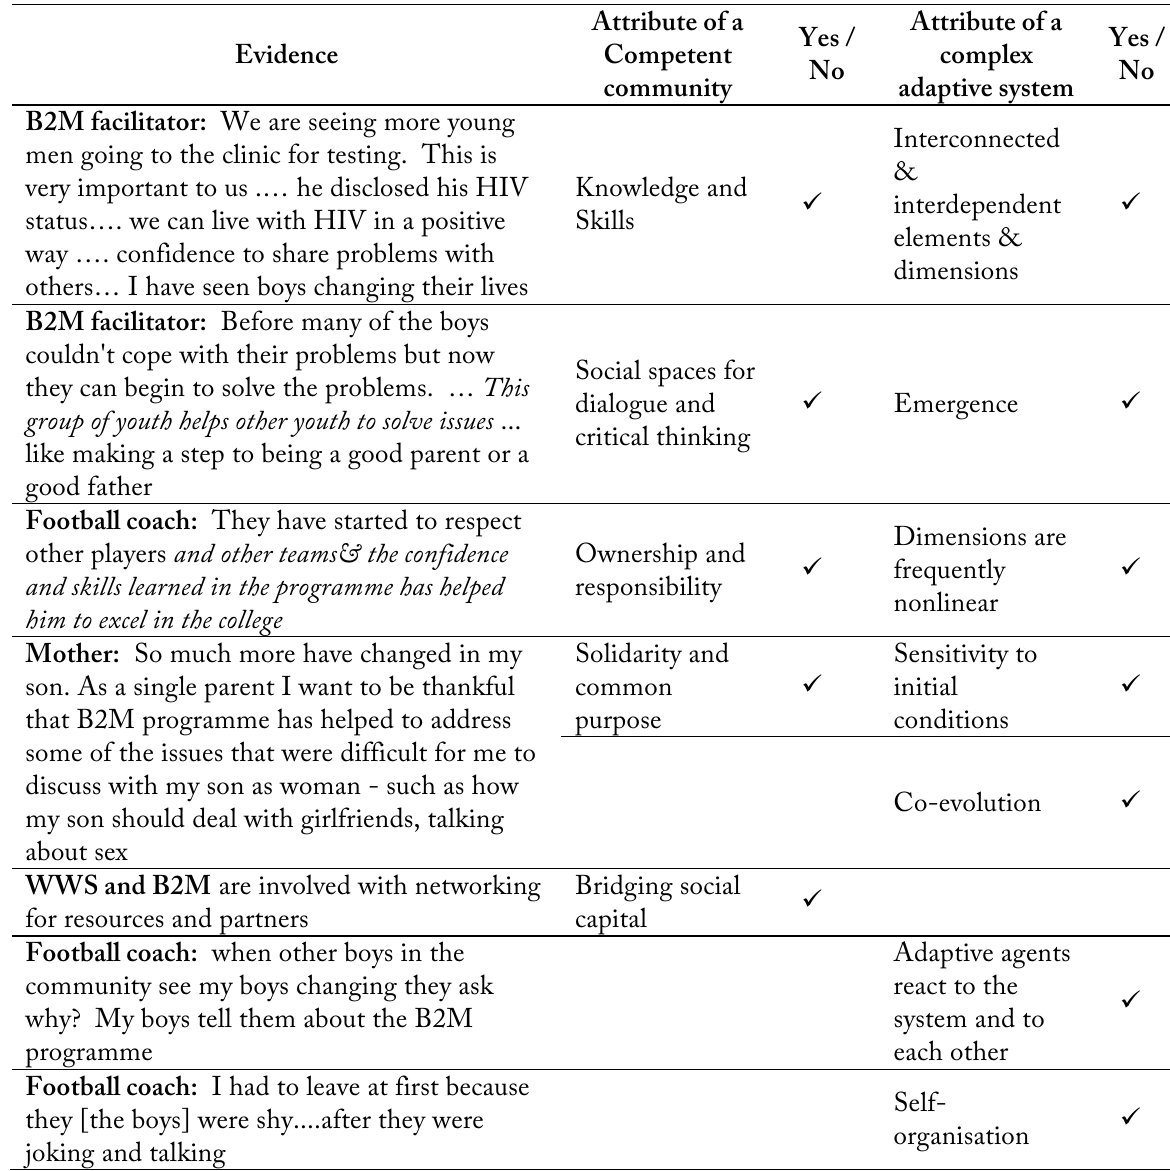
Table iii: Narrative fragments coded against both the competence and complexity